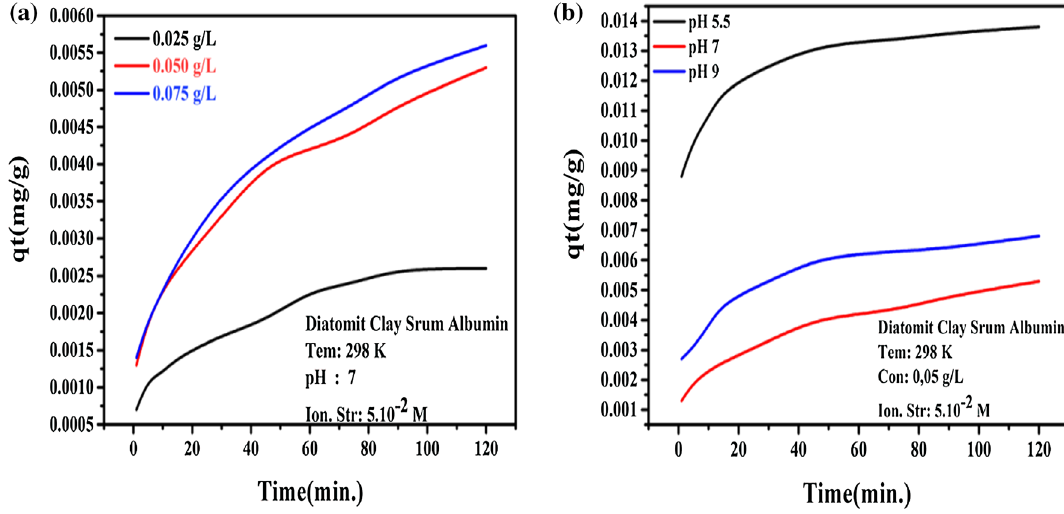
Fig. 1 The effect of a initial enzyme concentration and b pH to the adsorption rate of bovine serum albumin (BSA) on diatomite